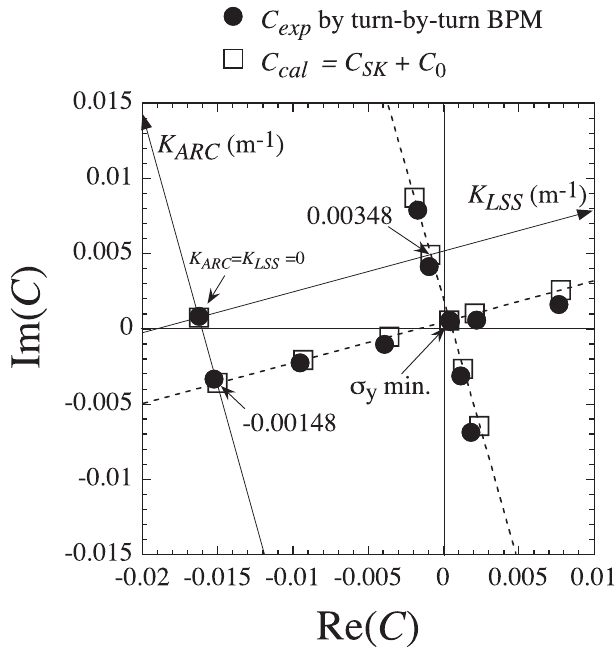
FIG. 5. The measured values C exp (filled circles) as a function of ð K ARC ; K LSS Þ are compared with C cal (open squares) calcu- lated from the given skew field strength. The working point was ð (cid:1) x ; (cid:1) y Þ ¼ ð 40 : 3509 ; 18 : 3477 Þ . The measured values are almost consistent with the calculations. The minimum absolute value of ; K 0 : 001 48 m (cid:1) 1 ; 0 : 003 48 m (cid:1) 1 Þ , C was given at ð K ARC LSS Þ ¼ ð(cid:1) where the minimum vertical beam size was realized, as shown